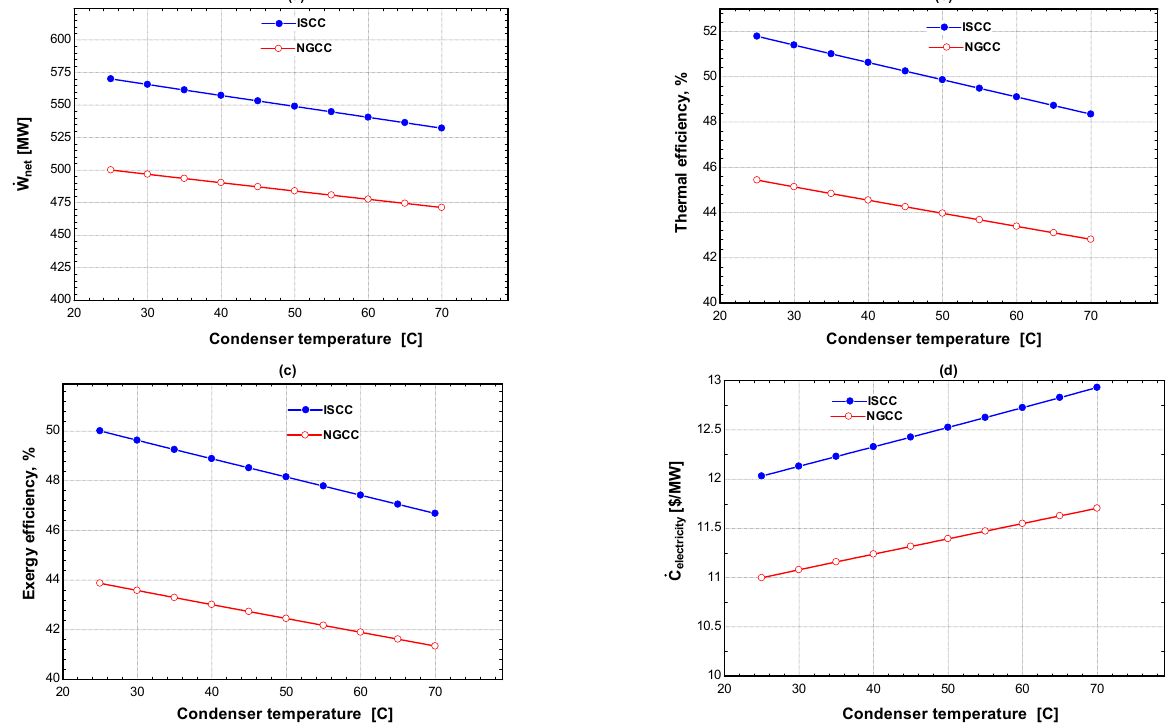
Figure 6. The effect of the condenser temperature on the overall performance and cost of both systems: ( a ) the total produced power, ( b ) thermal efficiency, ( c ) exergy efficiency, and ( d ) total rate of production costs.